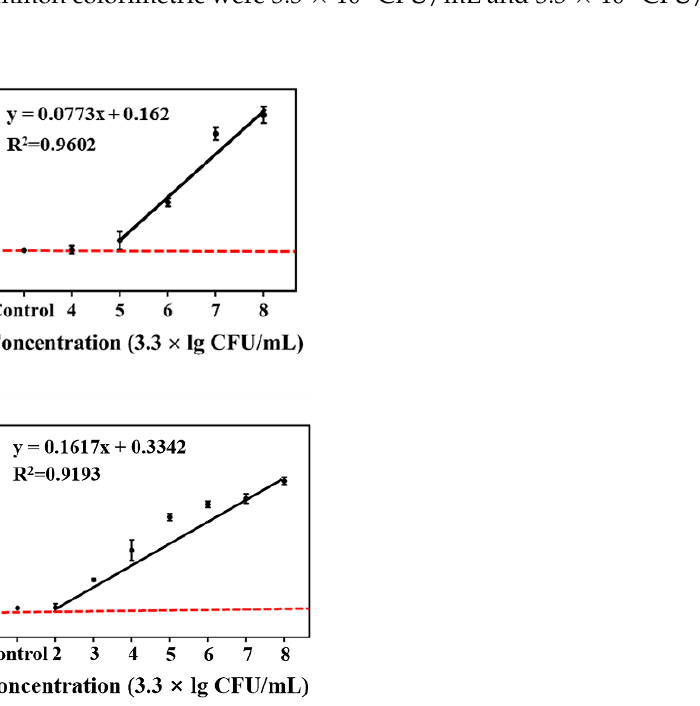
Figure 6. ( A ) The LOD and calibration curve of the common colorimetric detection method for S. aureus in pure culture. ( B ) The LOD and calibration curve of the AMS-DNFs amplification colormetric detection method for S. aureus in pure culture.